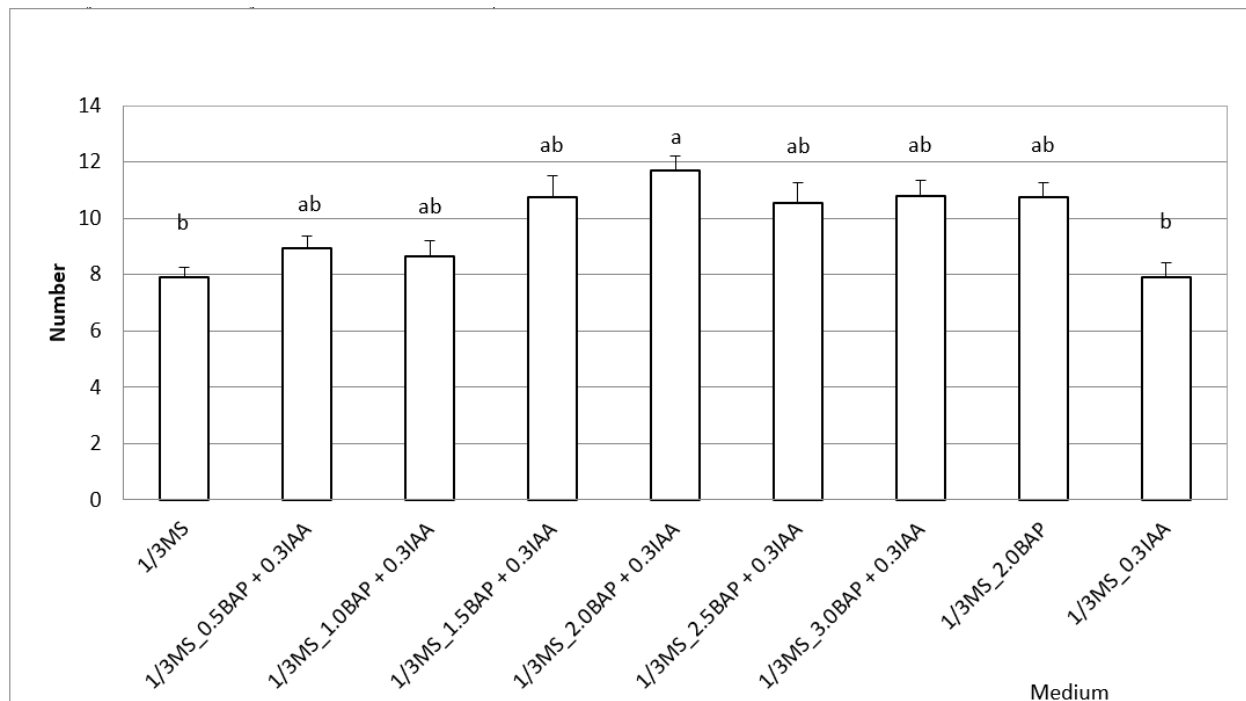
Figure 1. Summarized number of new shoots after two passages. Significance at p = 0.05. Values followed by the same letters are not statistically different in the Tukey test—one-way variance analysis.